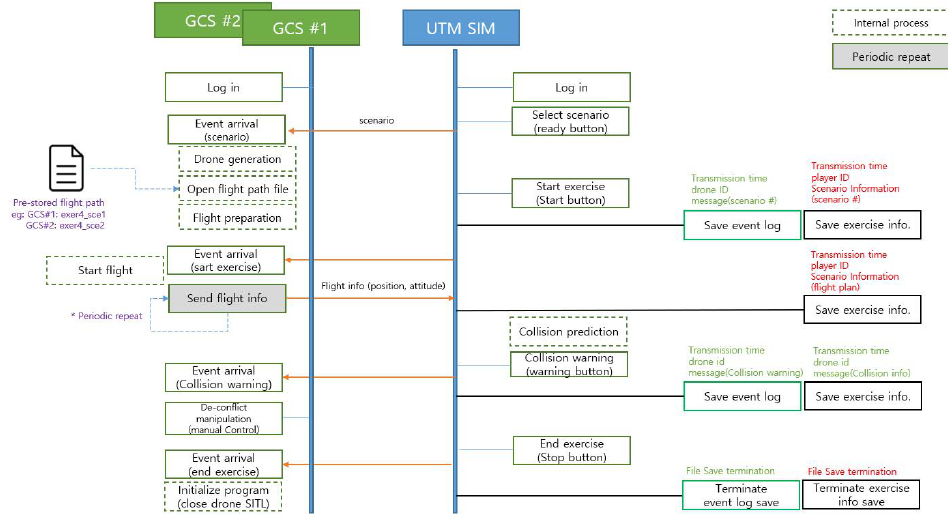
Figure 15. Scenario #3 (emergency by unexpected drone flights).